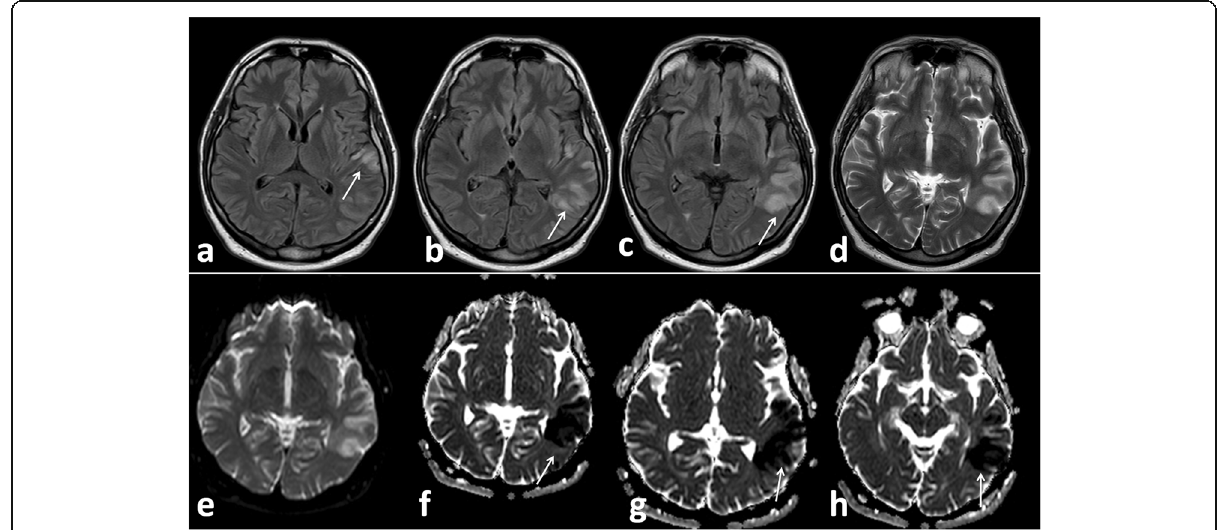
Fig. 11 Female patient 62 years old presented with coma. Left temporal infaction (white arrows in a , b , c , d ) restricted diffusion in ADC map (white arrows in f , g , h )